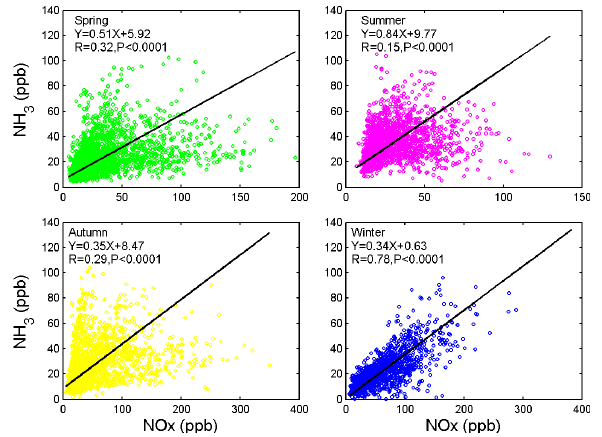
Fig. 8. The 2-sided regression of NH 3 versus CO at CMA in different seasons from June 2009 to May 2010.